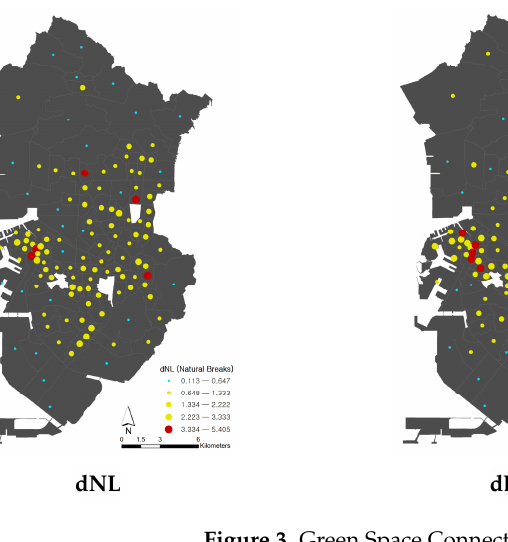
Figure 2. Hot/Cold Spots of Single-person Households for Each Age Group. Regarding park accessibility, a large gap existed in walking time, ranging from a minimum of 127 s to a maximum of 2487 s. The 10-minunte standard walking time to urban parks provided by the Ministry of Land, Infrastructure, and Transport (National Minimum Standards for Basic Living Infrastructure) was applied to derive administrative districts that fail to meet the standard. The results show that most of the city outskirts are below the standard walking time, and areas considered exceptional, such as Sangok-dong, Cheongcheon-dong, and Hyoseong-dong, were identified as mountainous lands. Since this study excludes parks in mountain areas, the above districts were considered to have weak park accessibility. In terms of green space connectivity, many districts in Namdong-gu and Bupyeong-gu showed a low dBC_IIC value, indicating the urgent need to strengthen connectivity, while Jung-gu and Michuhol-gu contained several districts that had relatively high dBC_IIC values (Figure 3). In the case of dNL and dBC_PC, administrative districts with low values were found in Seo-gu, Gyeyang-gu, and Yeonsu-gu. Districts within Jung-gu continuously had relatively high values for both indices.